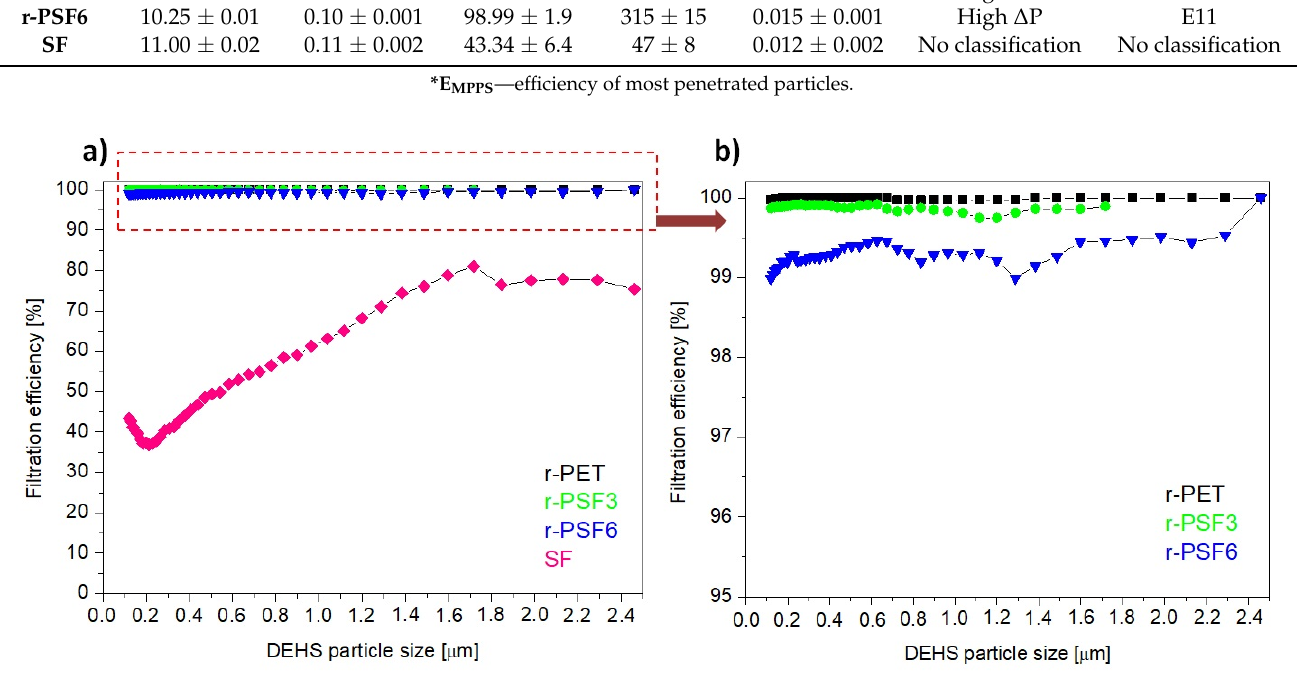
Figure 7. Filtration efficiency of investigated samples with basis weights between 10–12 g · m − 2 ; ( a ) r-PET (black sign), r-PSF3 (green sign), r-PSF6 (blue sign), SF (magenta sign); ( b ) detail of the curves at high efficiency.